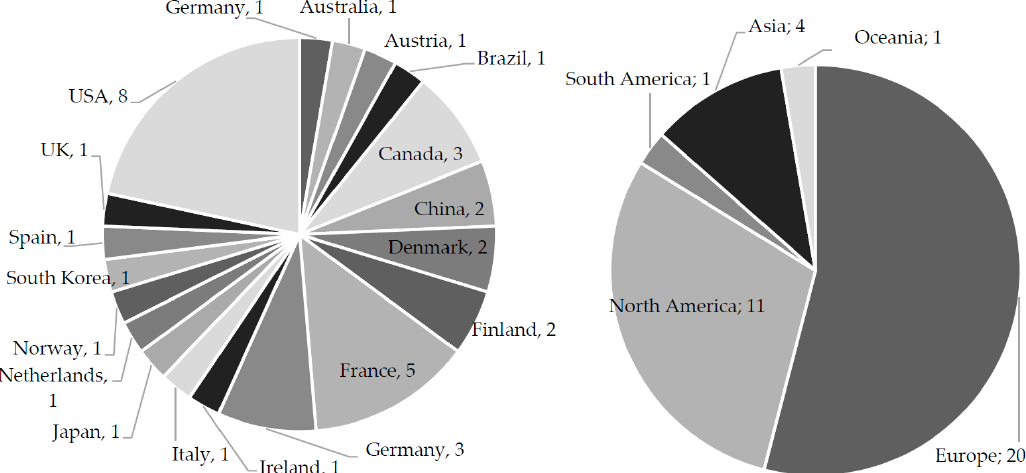
Figure 2. Geographical structure of the companies in the sample (by country—on the left and by region of the world—on the right ). Source: calculated and built by the authors.